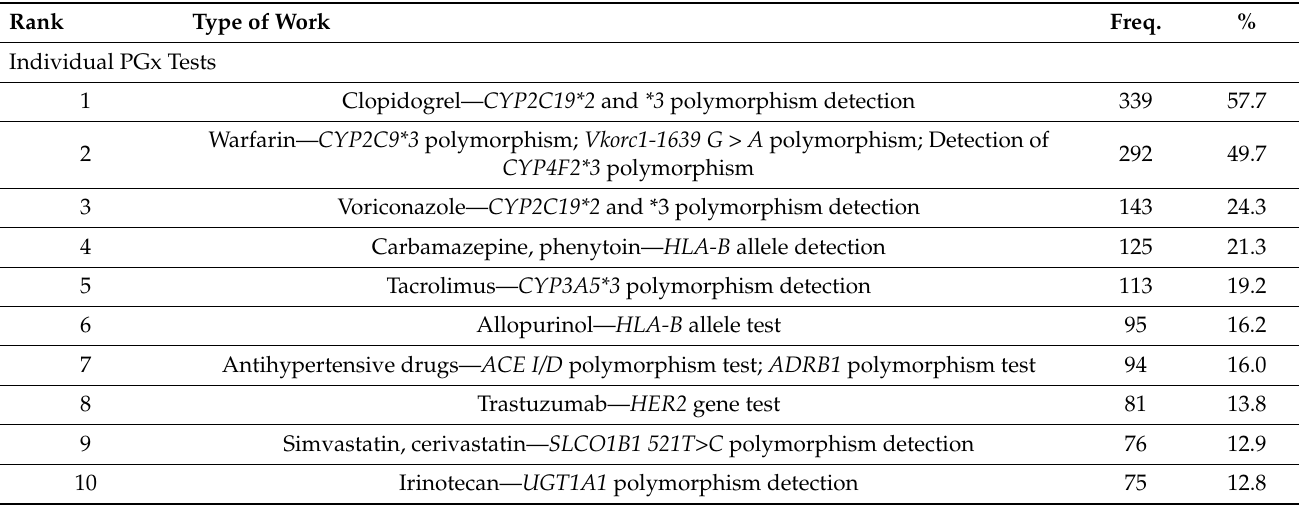
Table 3. Experience in individual PGx tests and multiple-gene PGx panel